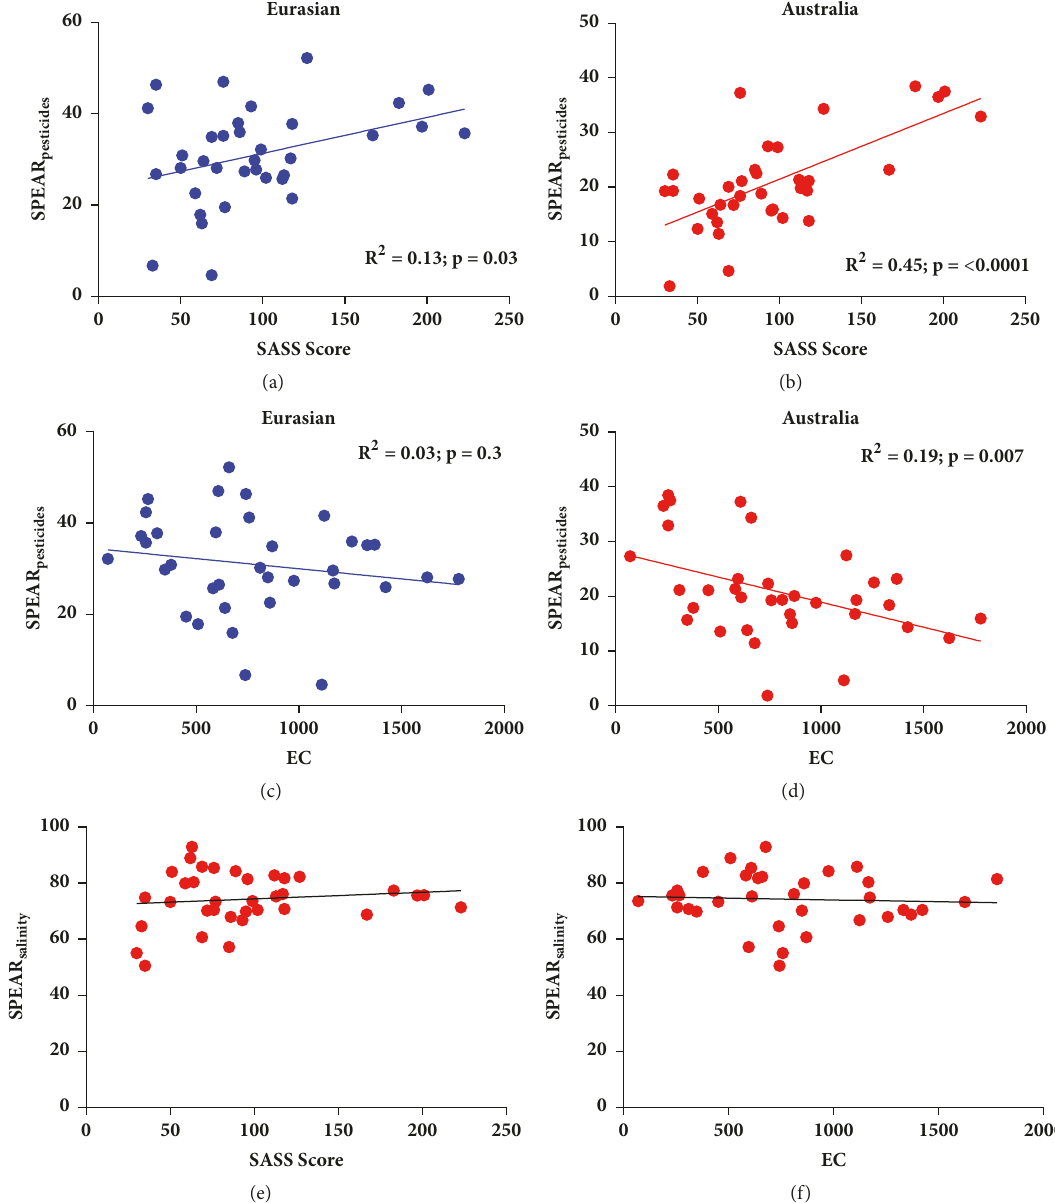
Figure 2: Linear regression indicating the relationships for (a) SPEAR pesticides (Eurasian database) and (b) SPEAR pesticides (Australian database) versus a biotic index, SASS5; (c) SPEAR pesticides (Australian database) and (d) SPEAR pesticides (Eurasian database) with the electrical conductivity (EC); (e) SPEAR salinity versus the SASS5 scores; and (f) SPEAR salinity versus